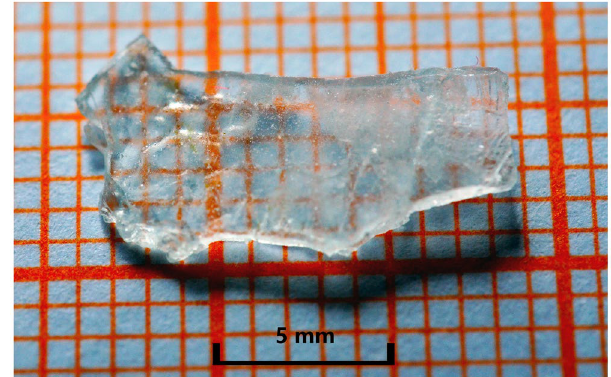
Figure 2. Photograph of the as-grown single crystal of CLVO.